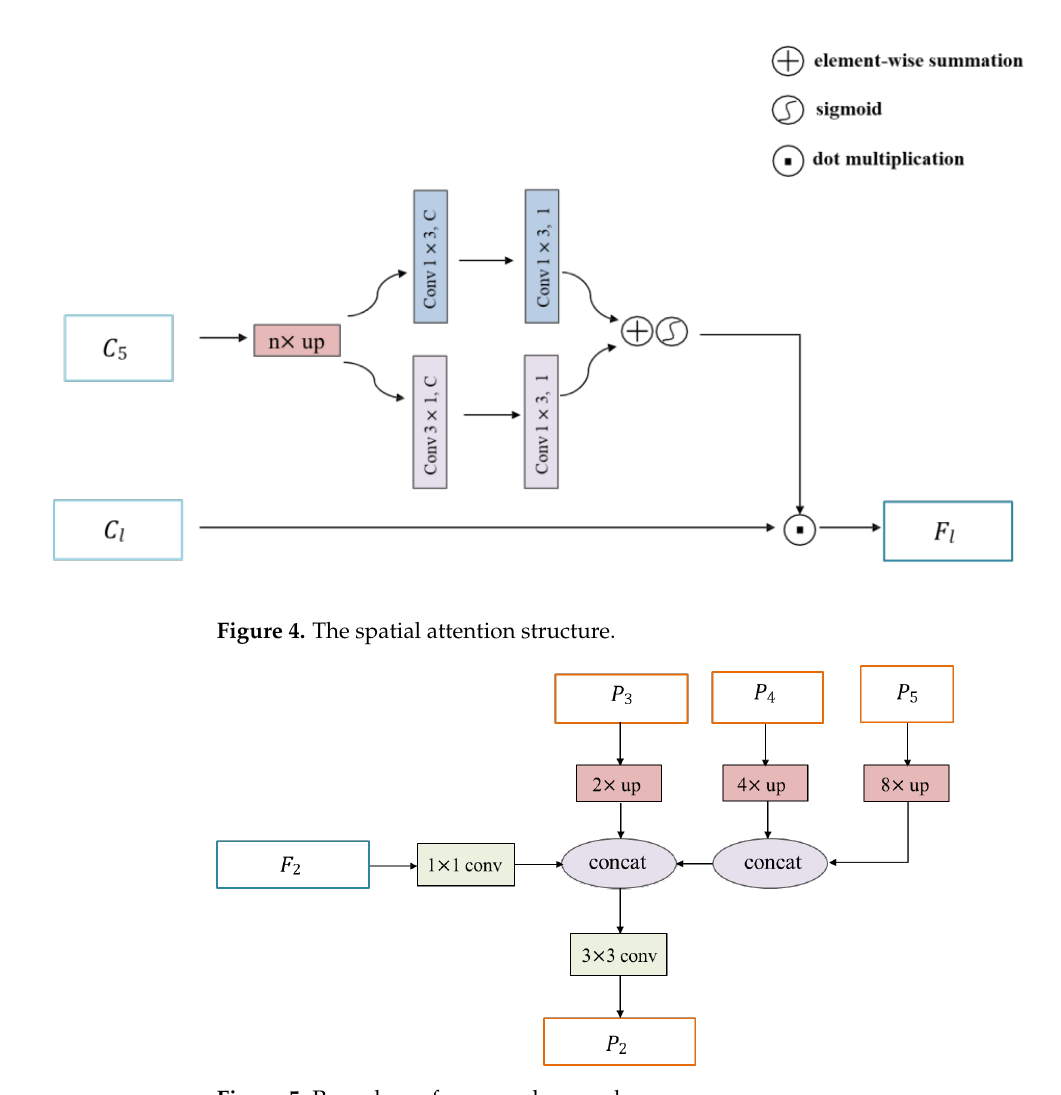
Figure 5. Procedure of cross-scale